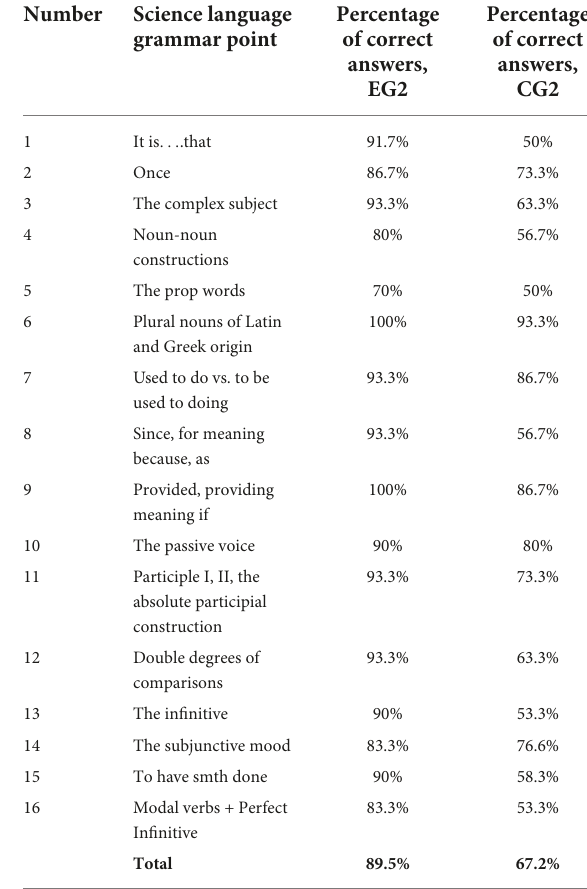
TABLE 5 End of the term results of Science language grammar course 2020–2021 academic